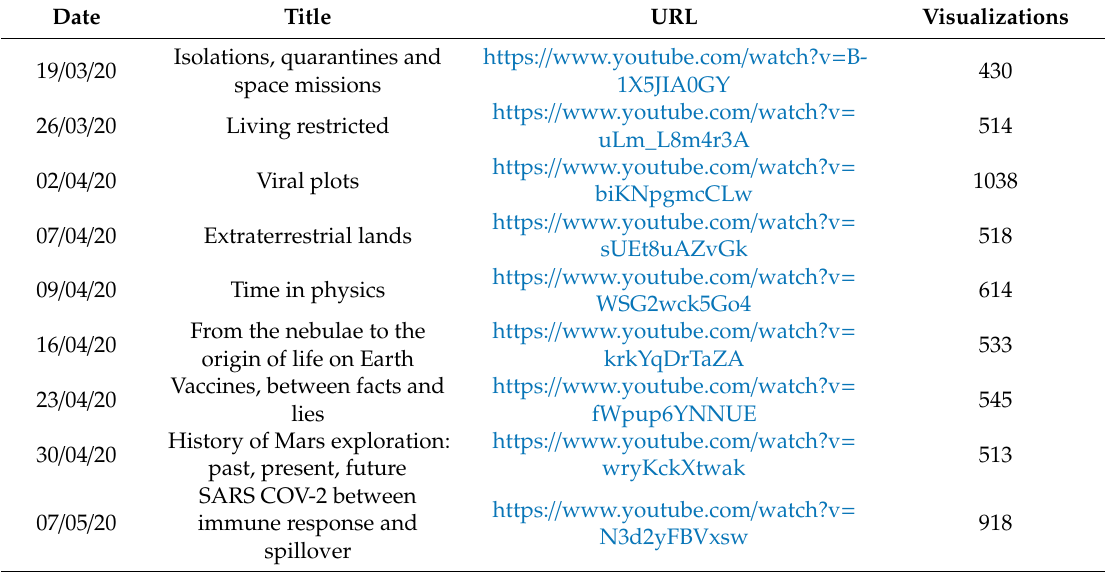
Table 1. List of online Science Caf é s organized by “Associazione Ca ff è -Scienza”, Firenze. Title URL